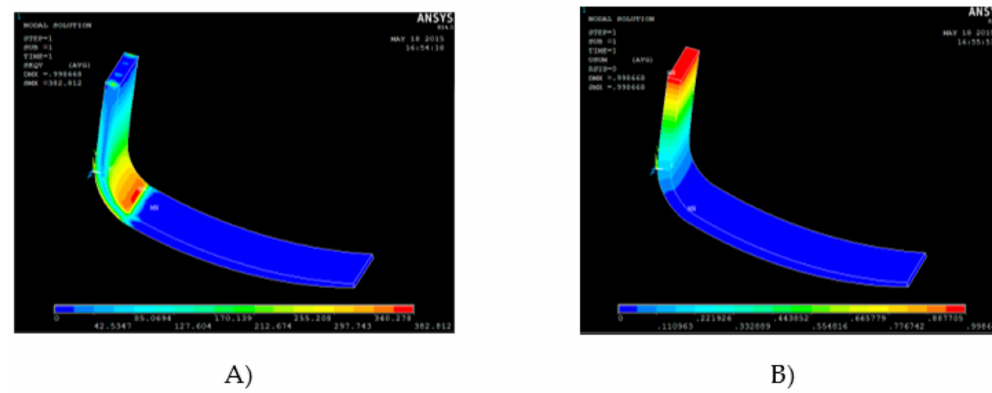
Figure 19. Case 1: Numerical analysis for MF. ( A ) Stress. ( B ) Deformation.